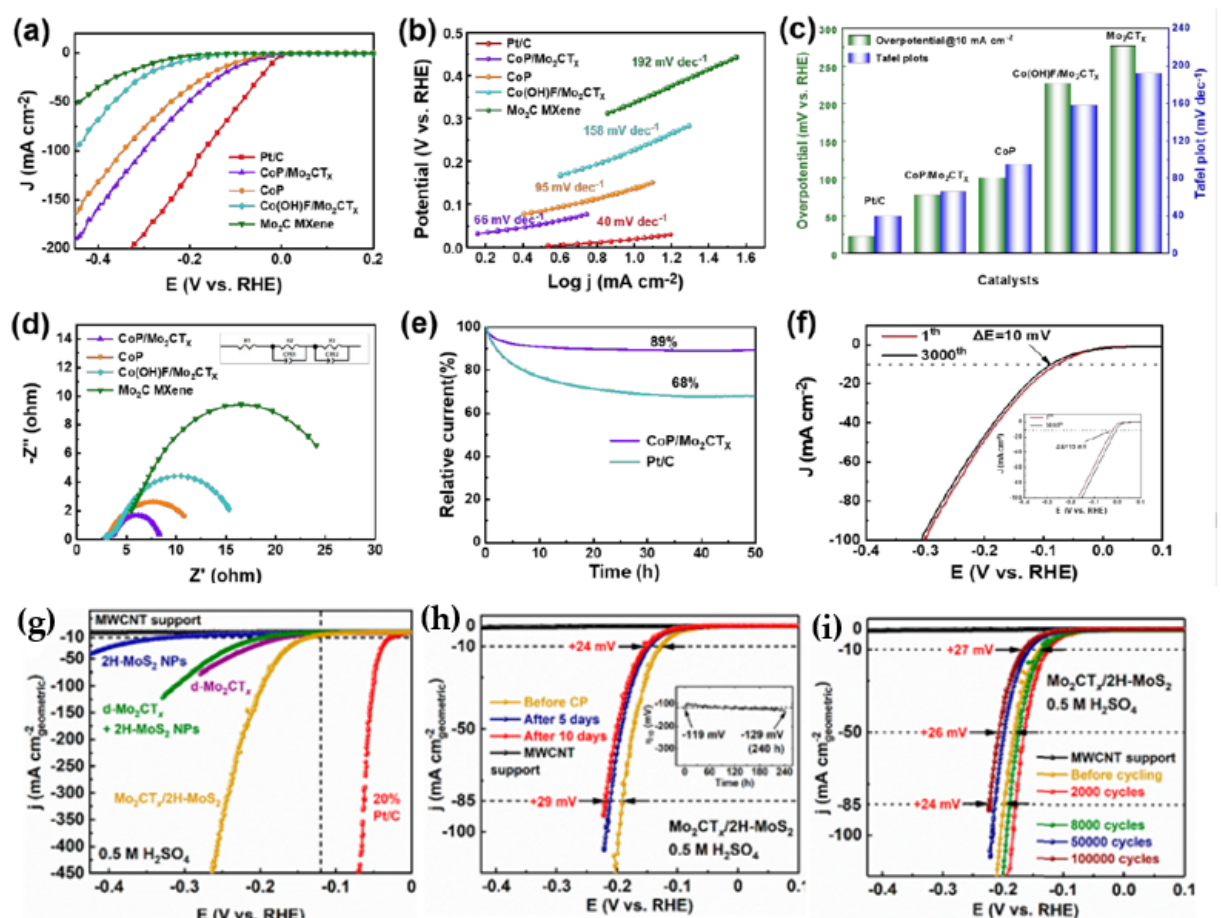
Figure 12. ( a ) LSV curves, ( b ) Tafel plots, ( c ) The Tafel slope and overpotential @10 mA cm − 2 for Pt/C, CoP/Mo 2 CT x , CoP, Co(OH)F/Mo 2 CT x , Mo 2 C MXene in 1 M KOH. ( d ) The electrochemical impedance spectra (EIS), ( e ) Chronoamperometric curves of CoP/Mo 2 CT x and Pt/C at the current density of 10 mA cm − 2 for 50 h. ( f ) LSV curves of CoP/Mo 2 CT x catalyst before and after 3000 CV cycles, and inset is the corresponding LSV curves before and after 3000 CV cycles for Pt/C. Reprinted with permission from Ref. [100]. Copyright 2021, Royal Society of Chemistry. ( g ) iR-corrected CV polarization curves for Mo 2 CT x /2H-MoS 2 nanohybrid in 0.5 M H 2 SO 4 after ( h ) 10-day CP (constant current at − 10 mA cm − 2geom , inset shows time-dependent iR-corrected overpotential during CP) and ( i ) 100,000 accelerated CV cycling at 100 mV s − 1 . HER electrochemical stability results of (Reprinted with permission from Ref. [102] Copyright 2020 American Chemical Society).